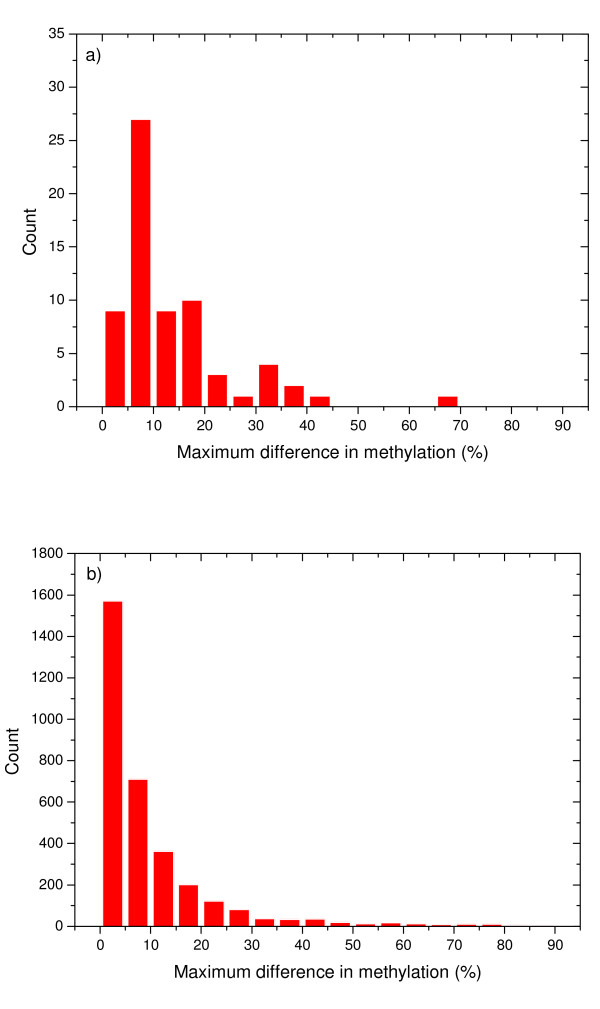
Distribution of the maximal methylation differences between CpGcluster islands within SWA (TJ) islands. a) HEP methylation data; b) Lister's methylation data [33].